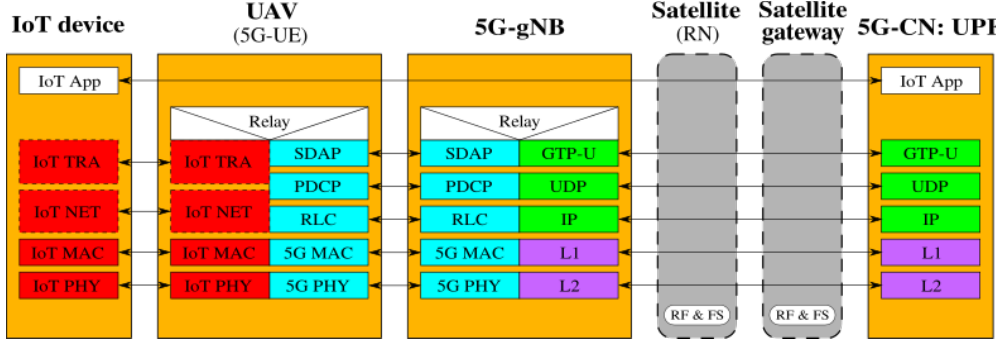
Figure 3. 5G-UE on the UAV, 5G-gNB on the ground close to the UAV, and the satellite as the backhaul between 5G-gNB and 5G-CN.